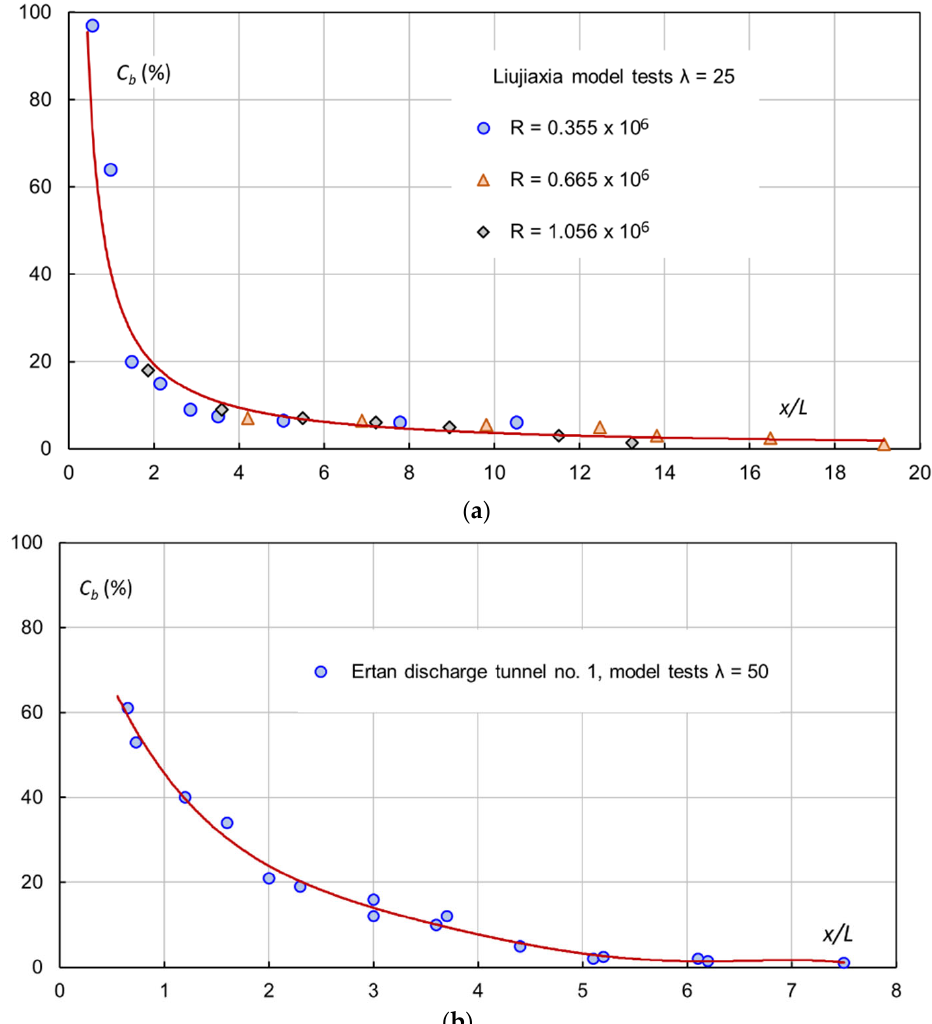
Figure 15. Layout of Ertan flood discharge tunnel, with five aerators (three are shown here). C1, C2 and C3 are prototype measurement points of bottom air concentration.